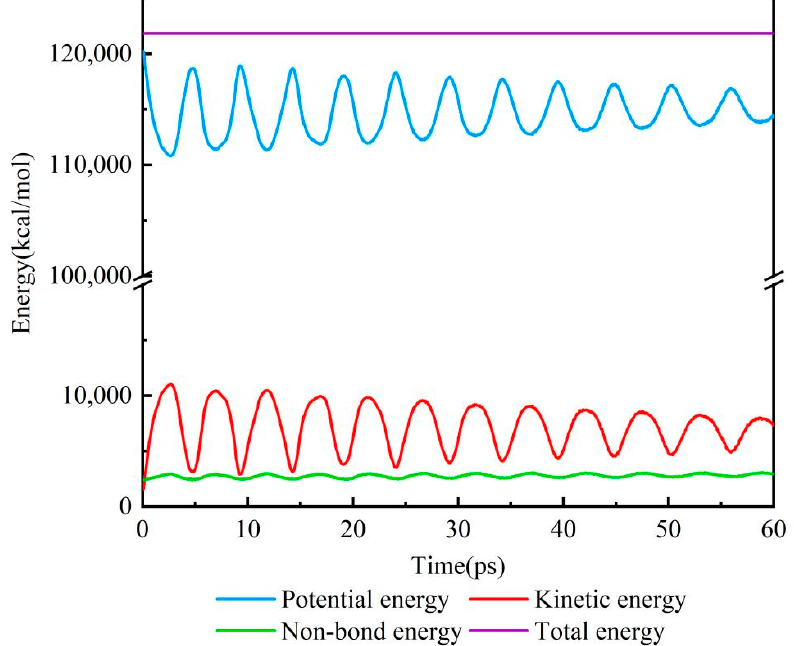
Figure 3. Energy of graphene nanoribbons during vibration.